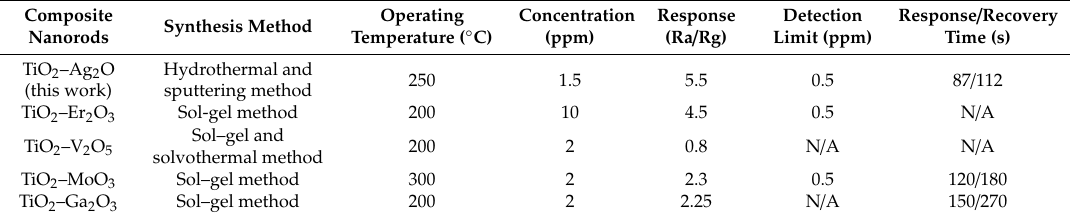
Table 1. NO 2 gas-sensing performance of various TiO 2 -based composites prepared using various methods in the operating temperature range of 200–300 ◦ C